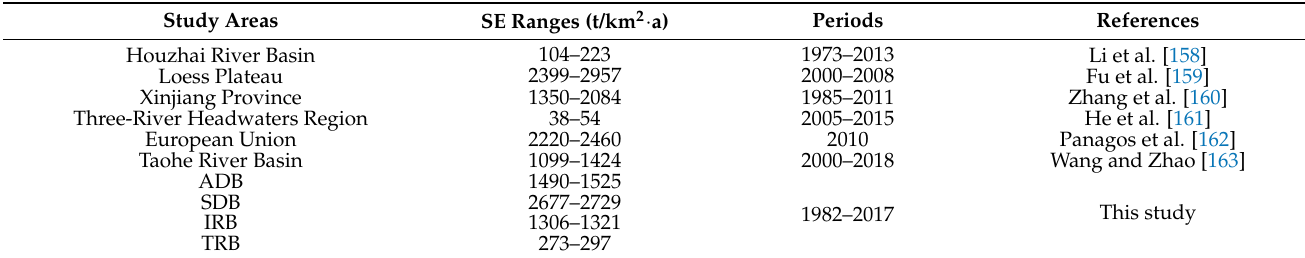
Table 2. Comparative analysis of SE with other surrounding areas.